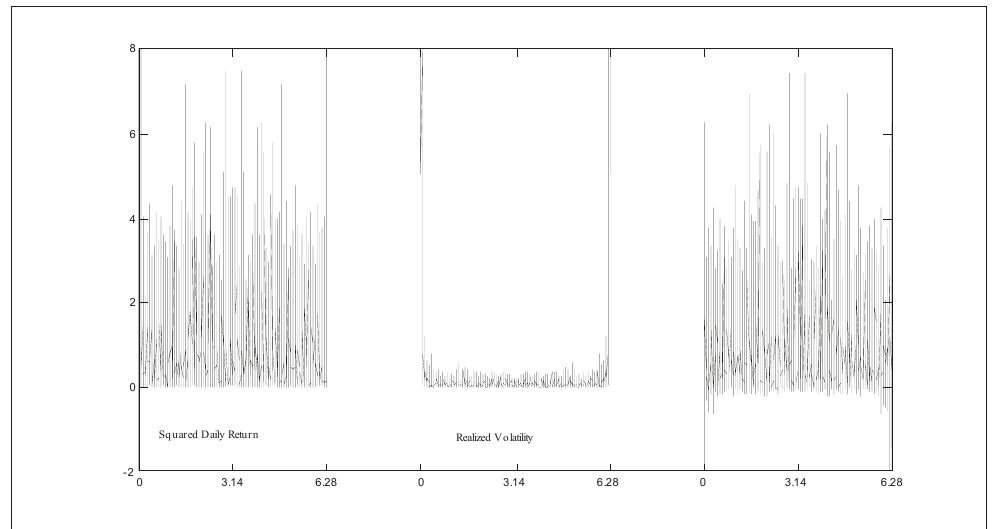
Figure 4. The periodogram of the log squared daily returns ( left ), the log realized volatility obtained from 1-min returns ( middle ), and the difference between them ( right ) for the high-frequency S&P 500 returns data. The sample period is from 7 October 1986 to 2 March 2007.